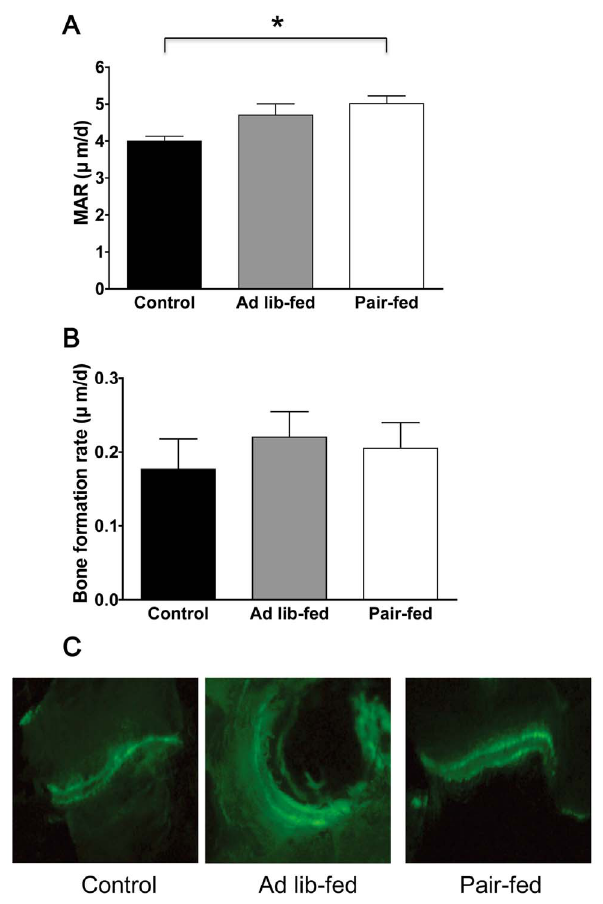
Figure 3. Effect of chronic ICV ghrelin infusion on the dynamic parameters of histomorphometric analyses. (A–B) Dynamic histomorphometric analyses of lumbar spine, including mineral apposition rate (MAR) and bone formation rate (BFR). (C) Representative fluorescent images obtained from lumbar spine after calcein double labeling (100 6 magnification). Three groups of rats (4–6 per group) were infused for 21 days with saline or ghrelin (1.5 m g/day). Rats infused with ghrelin were ad lib -fed or pair-fed (to saline-infused rats). * P , 0.05; Data are presented as the mean 6 SEM.